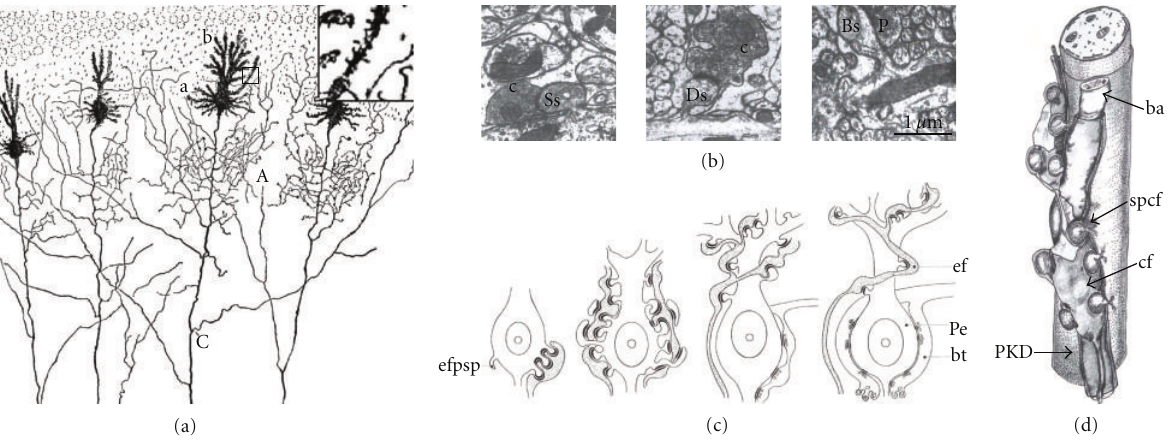
Figure 7: (a) Illustrates a scientific drawing by Cajal [7, Figure 418]. Purkinje cells, cerebellum, newborn child, and Golgi method. Supernumerary collaterals of the Purkinje axon (A); inferior collaterals (C); somawith indi ff erent appendages (a); formationof the definitive branches (b); inset shows dendritic spines digitally enlarged of the boxed region. (b) Purkinje cell; from left to right, perisomatic spines synapsing (Ss) on climbing fibers (c); dendritic spines (Ds) of large dendrites synapsing on climbing fibers (c); dendritic spines of Purkinje cell dendritic branchlets that synapses on parallel fibers (p; [21]). (c) sketch of the evolution of the climbing fibers and dendritic spines based on electron microscopy observations [15]. (d) cluster of dendritic spines (spcf) connecting with a climbing fiber (cf)